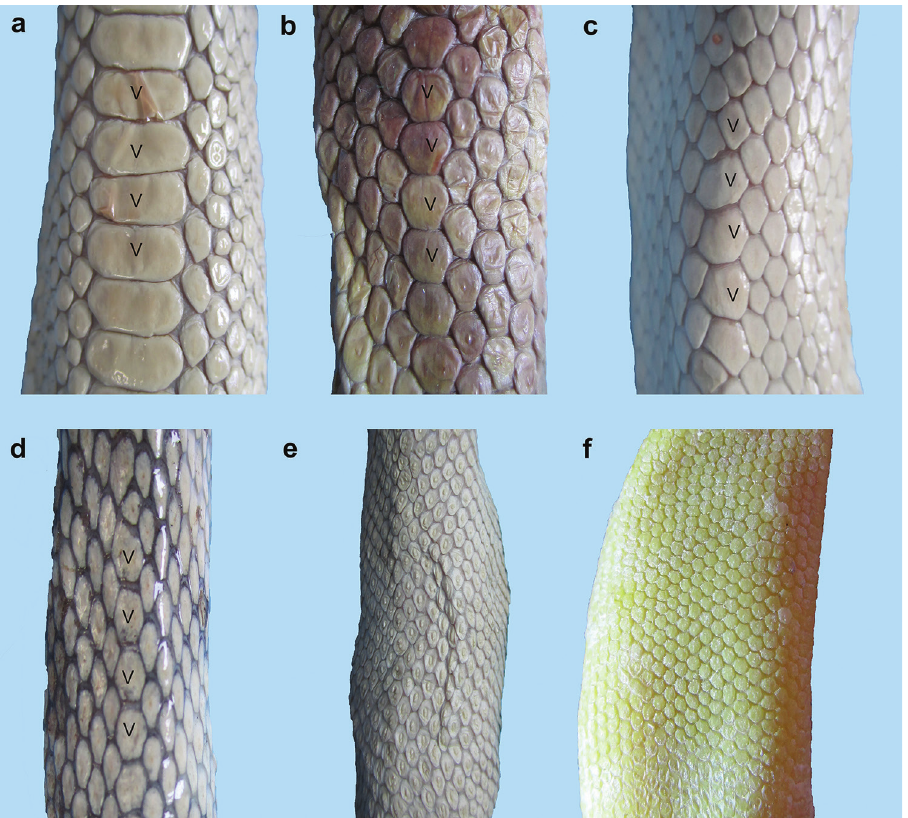
Figure 4. Various shapes of ventrals on the mid-body of sea snakes of the genus Hydrophis in the Persian Gulf and Gulf of Oman: a wide and enlarged, more or less rectangular in shape ( Hydrophis viperinus ) b medium size, distinguishable from the adjacent scales, more or less hexagonal in shape ( H. curtus ) c and d small and slightly distinguishable from adjacent scales ( H. ornatus and H. lapemoides , respectively) e and f small and more or less indistinguishable from adjacent scales ( H. schistosus and H. platurus ,